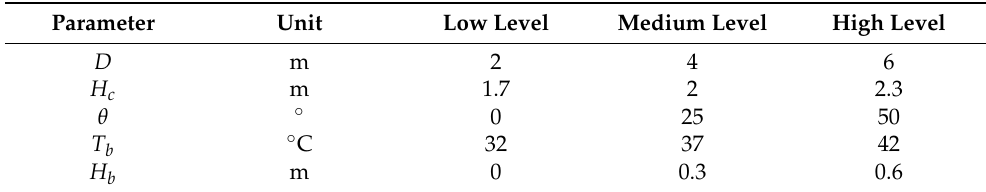
Table 1. Levels of investigated parameters for the RSM modeling. D , H c , θ , T b , and H b represent the horizontal distance, the camera height, the angle of view between the camera and black body cavity, the black body cavity temperature, and the black body cavity height, respectively.